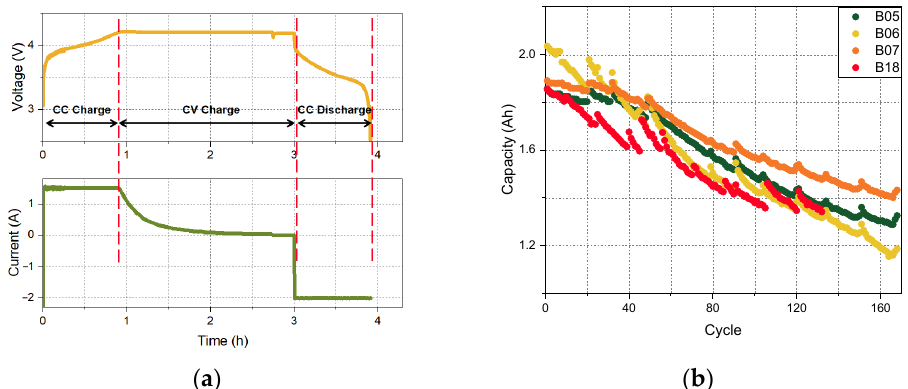
Figure 1. The experimental steps and capacity degradation profiles: ( a ) The voltage and current in a test cycle; ( b ) Capacity aging trends of the four batteries.